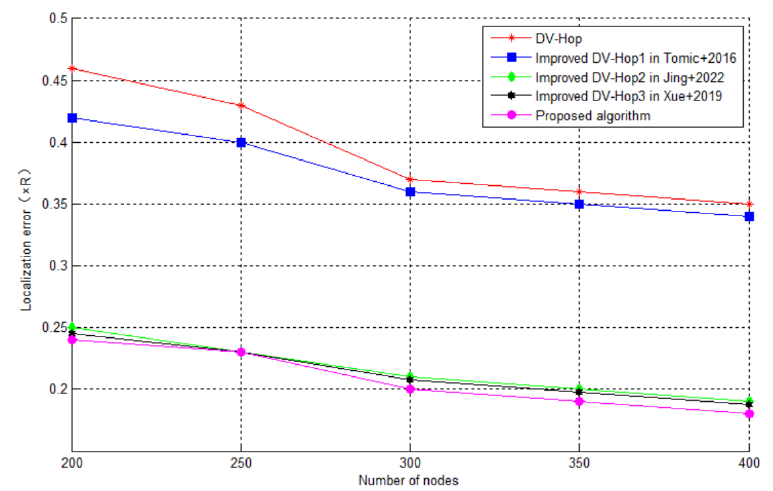
Figure 8. Comparison of localization errors of different total number of nodes [21–23].